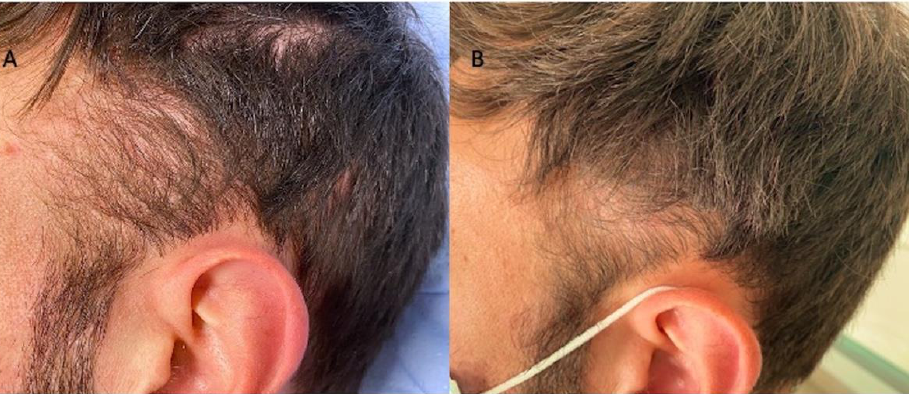
Figure 5. Caucasian male patients were treated with MND and LLLT protocols. ( A ) Pre-operative view of the scalp of 35-year-old male patient affected by AGA II according to Norwood – Hamilton scale with hair loss localized in the frontal, temporal, and parietal area; ( B ) post-operative view at T1-16 wks after MND and LLLT treatment with detail of HR-G in the temporal